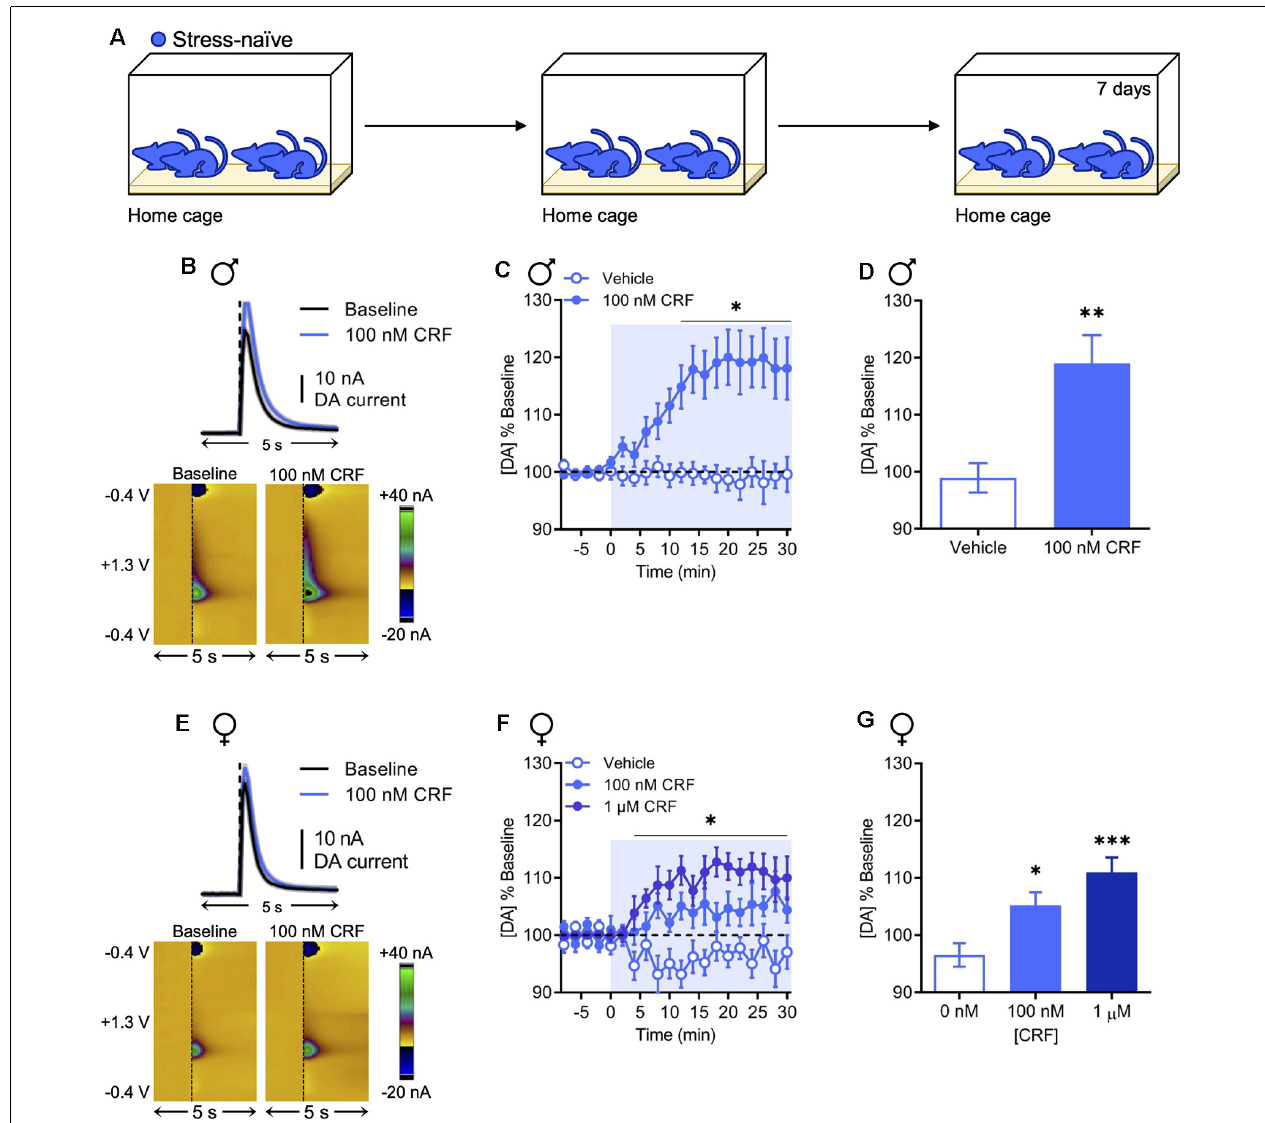
FIGURE 1 | Corticotropin-releasing factor (CRF) increases dopamine release in the nucleus accumbens (NAc) in stress-naïve males and females. (A) In the stress-naïve experimental group, mice remained in their home cage for the duration of the experiment. (B) Representative dopamine release evoked by electrical stimulation (dashed line) before and after application of 100 nM CRF to a NAc brain slice collected from a stress-naïve male (mean ± SEM for five consecutive stimulations, top) and corresponding two-dimensional plots depicting changes in faradaic current (pseudocolor) with time as the abscissa and applied potential as the ordinate (bottom). (C) Baseline-normalized mean peak amplitude of electrically evoked dopamine release over time in response to vehicle ( n = 9) or 100 nM CRF ( n = 11) application to NAc slices from stress-naïve males. (D) Baseline-normalized mean peak amplitude of dopamine release 20–30 min after vehicle ( n = 9) or 100 nM CRF ( n = 11) application to NAc slices from stress-naïve males. (E) Representative dopamine release evoked by electrical stimulation (dashed line) before and after application of 100 nM CRF to a NAc brain slice from a stress-naïve female (mean ± SEM for five consecutive stimulations, top) and corresponding color plots (bottom). (F) Baseline-normalized mean peak amplitude of electrically evoked dopamine release over time in response to vehicle ( n = 10), 100 nM CRF ( n = 8), or 1 µ M CRF ( n = 8) application to NAc slices from stress-naïve females. (G) Baseline-normalized mean peak amplitude of dopamine release 20–30 min after vehicle ( n = 10), 100 nM CRF ( n = 8), or 1 µ M CRF ( n = 8) application to NAc slices from stress-naïve females. Error bars, SEM. ∗ P < 0.05, ∗∗ P < 0.01, ∗∗∗ P < 0.001 vs.